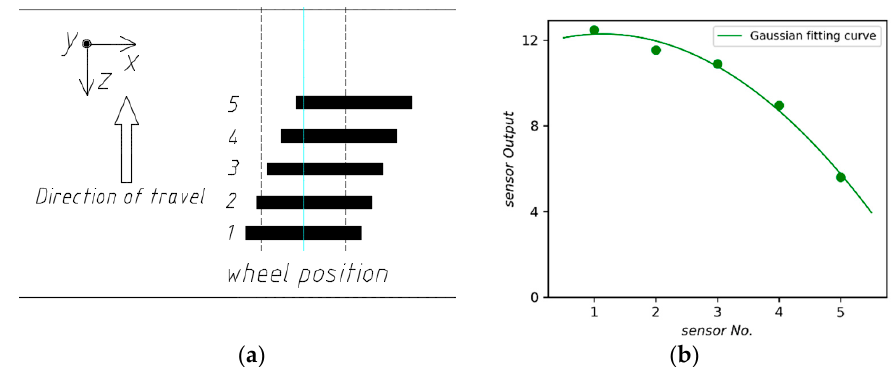
Figure 20. ( a ) The array with five lateral sensors; ( b ) Gaussian fitting curve.